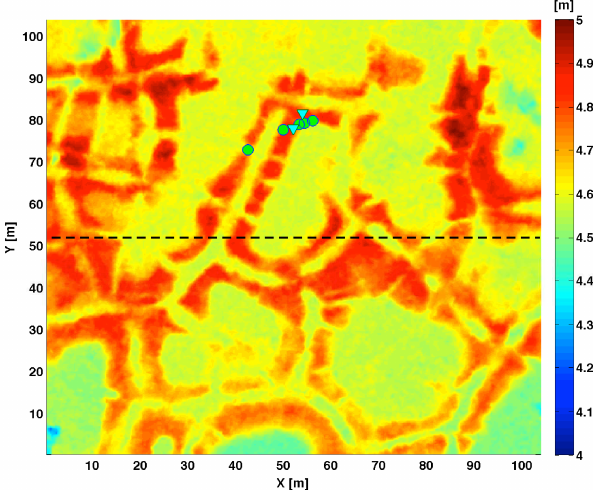
Figure 1. The NGEE-Arctic study area A, which was character- ized as a low-centered polygon field. The dotted line indicates the transect along which the simulations in this paper are performed to demonstrate the effects of snow redistribution on soil temper- ature. The locations where snow and temperature sensors are in- stalled within the study site are denoted by triangles and circles,